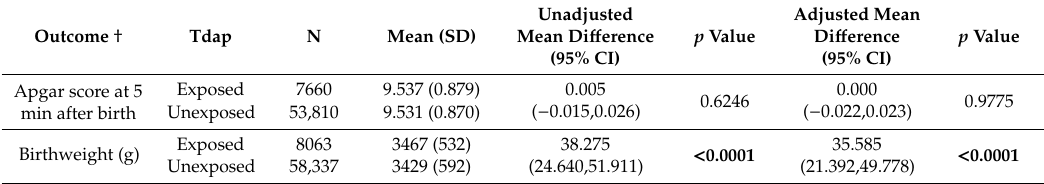
Table 3. E ff ect of maternal Tdap on infant’s Apgar score at 5 min after birth and birthweight at delivery, on eligible maternities, * by Tdap exposure, New Zealand (N Exposed = 8299; N Unexposed = 61,090; N Total =